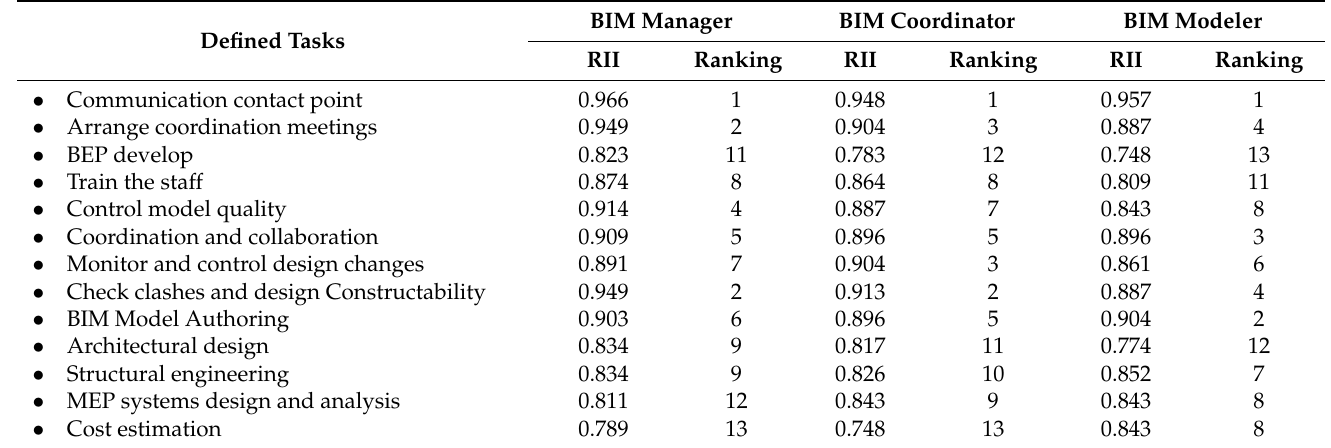
Table 4. The importance level of BIM-related tasks, ranked by questionnaire